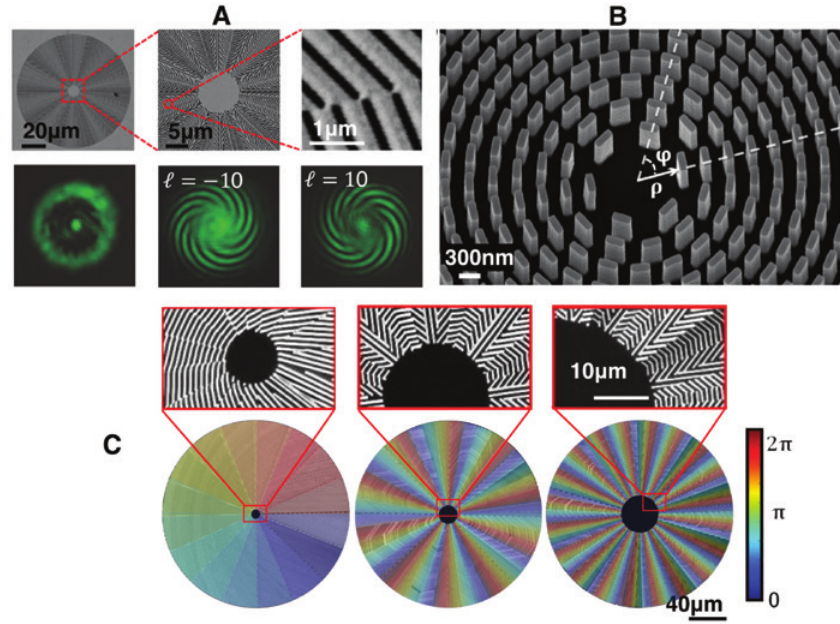
Figure 3: Optical vortex beam generated by geometric phase metasurfaces. (A) A geometric phase metasurface based on gold nanoslits generates optical vortex beams with topological charge ℓ = ± 10, when incident is left-hand or right-hand circularly polarized, respectively. Reprinted from Ref. [139]. (B) A dielectric metasurface composed of TiO with orientation varying from 0 to 2 π induces a geometric phase from 0 to 4 π along the azimuthal direction. Reprinted from Ref. [140]. (C) Geometric phase plates generates high orders of optical vortex beams fabricated by femtosecond laser printing. Reprinted from Ref.